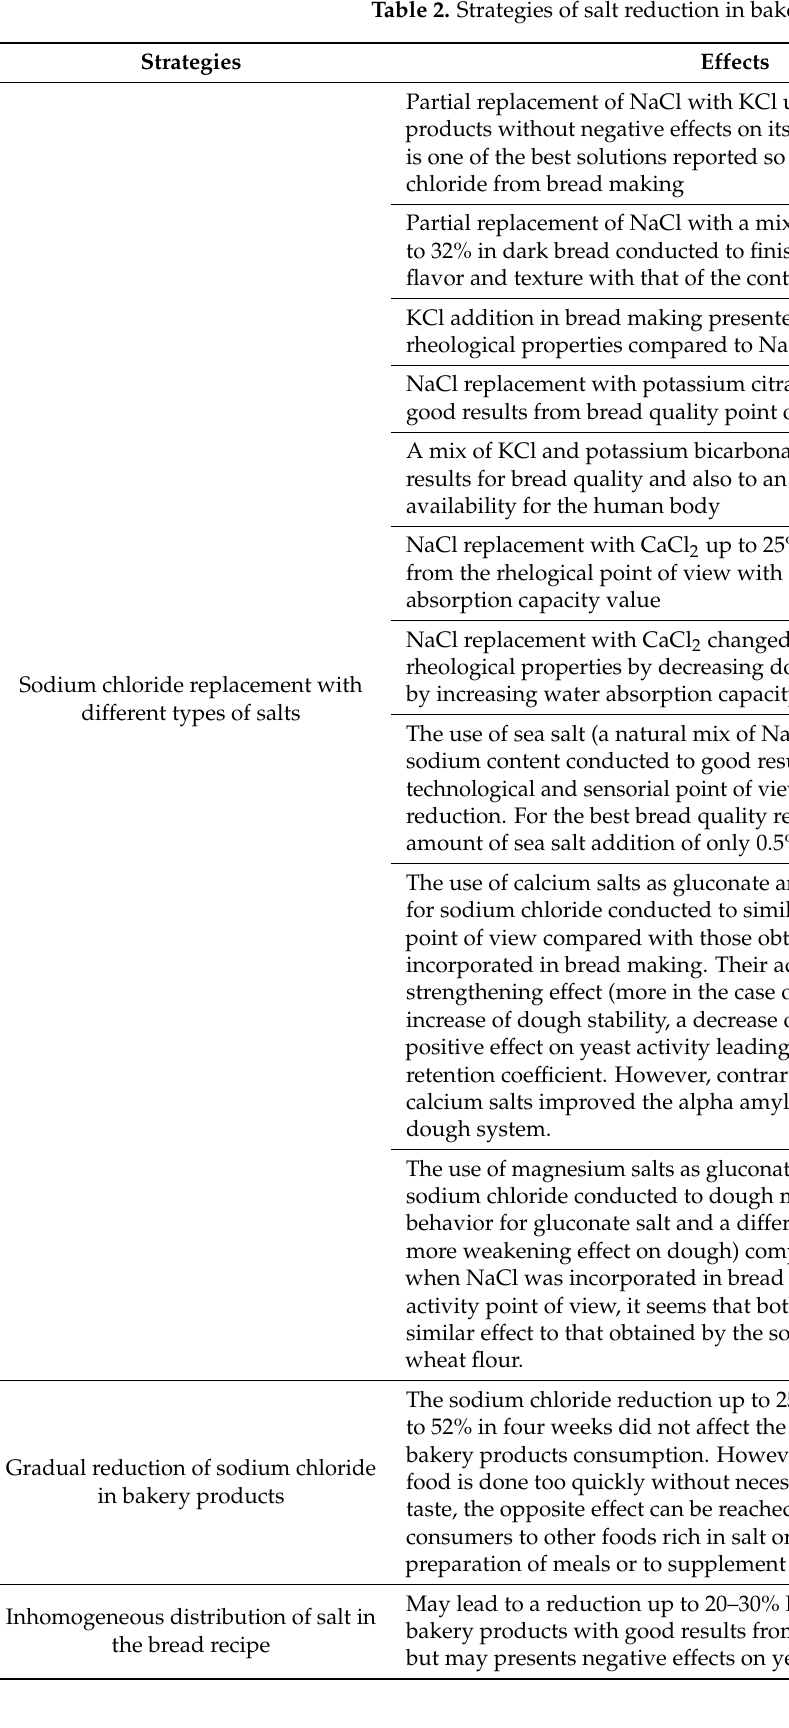
Table 2. Strategies of salt reduction in bakery